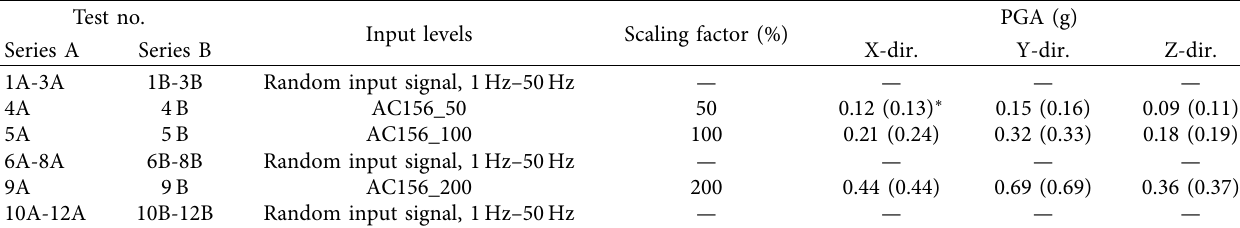
Table 3: Input and test protocol for